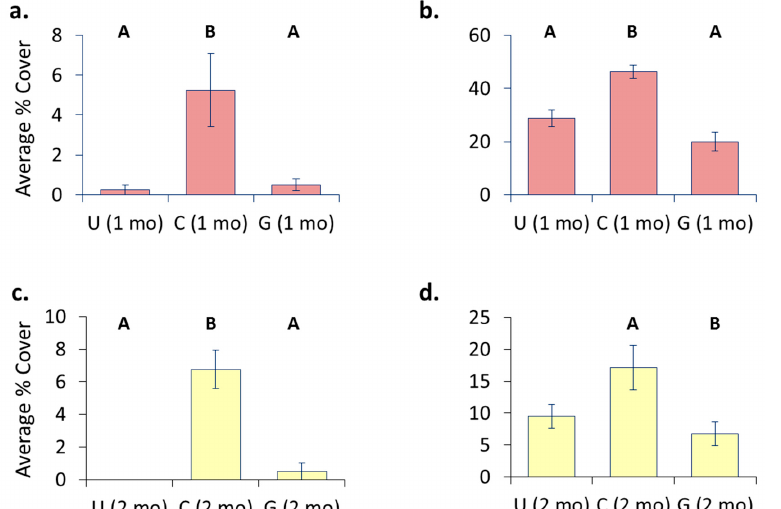
Figure 11. Differences in fouling due to prior husbandry, uncleaned dominance. ( a ) Cover of macro- fouling on 3140 at Port Canaveral in September was significantly higher on uncleaned and cleaned than on groomed ones on panels that came from the Port ( p < 0.001). ( b ) Cover of encrusting bryozoans on 3140 at Sebastian in September was significantly higher on uncleaned than on cleaned or groomed panels ( p = 0.011). The X-axes are treatments; the Y-axes are average percent cover. Please note that Y-axes vary. Treatments are uncleaned (U), cleaned (C) and groomed (G). The time in the parenthesis is elapsed time since cleaning and transplant. Letters above the bars denote sta- tistical significance (i.e., As are statistically similar to, but significantly different than, Bs).